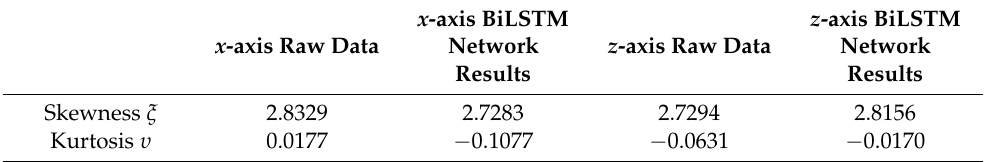
Table 5. The normality test results. Table A5. The normality test results.